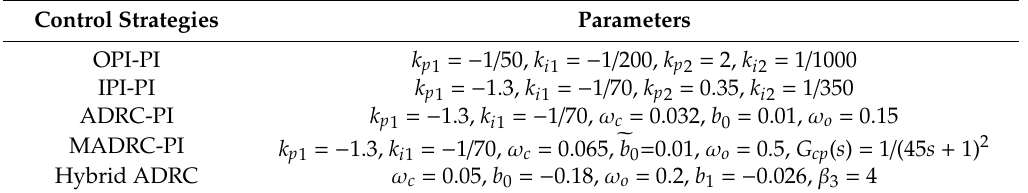
Table 1. Parameters of di ff erent control strategies for numerical